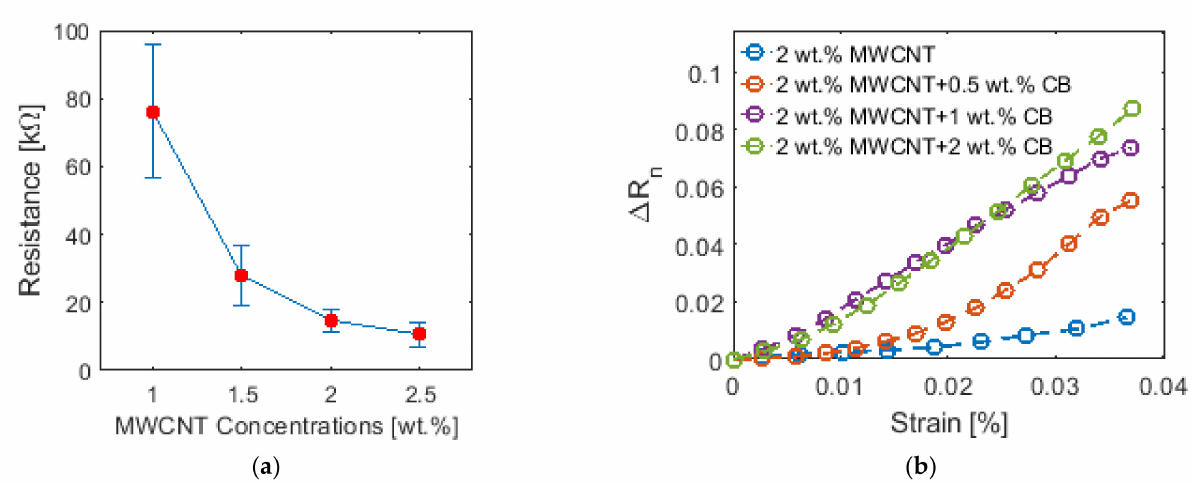
Figure 6. ( a ) The average electrical resistance of different MWCNT concentration nanocomposite paint specimens and their corresponding error bars (standard deviations) are plotted. ( b ) The normalized change in resistance of different paint formulations were plotted against applied strains to examine strain sensing linearity and the effects of adding